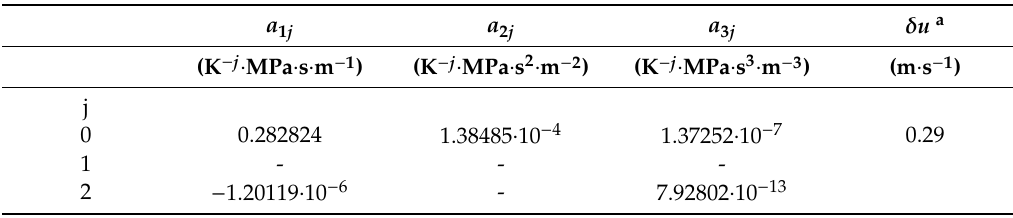
Table 4. Coe ffi cients of Equation